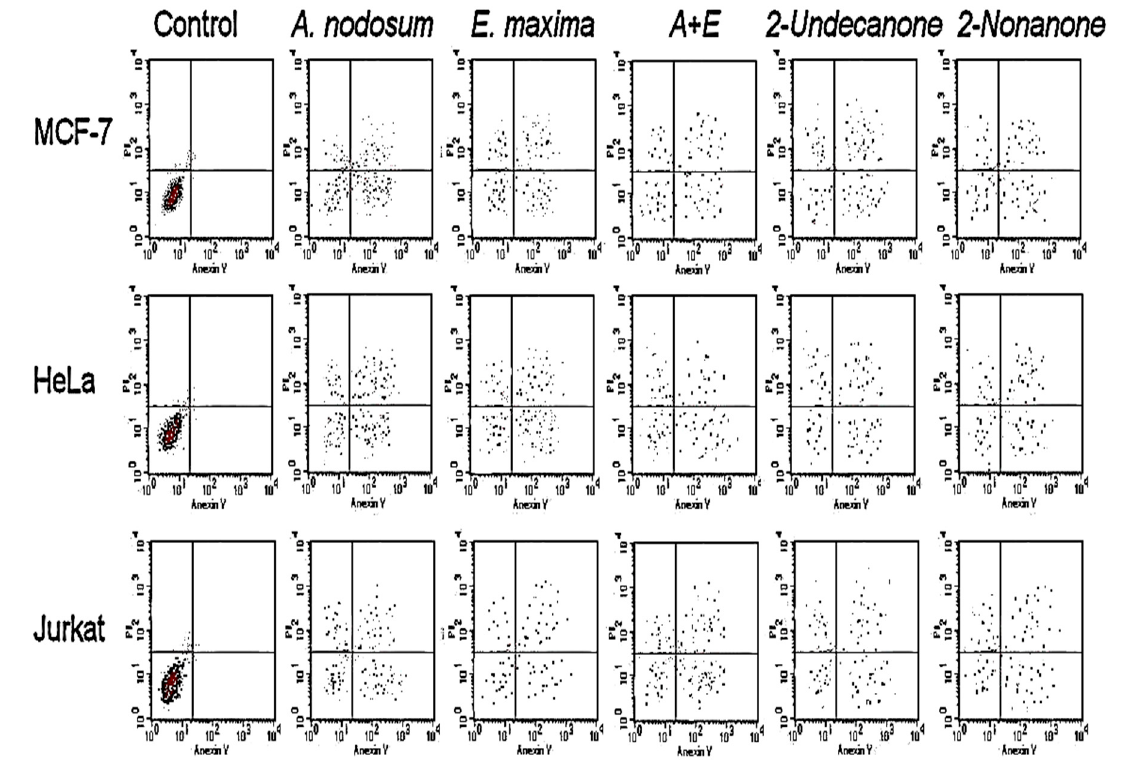
Figure 4. Response of different cancer cells in the apoptotic cell population assay using flow cytometry to seaweed treatments, 2-undecanone, and 2-nonanone.